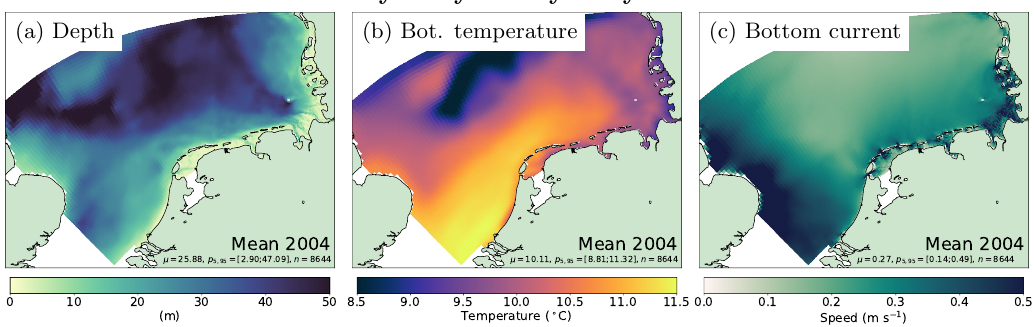
Figure 3. Simulated annual average near-bottom hydrography (from left to right: water depth, bottom temperature, bottom current speed), shown for the year